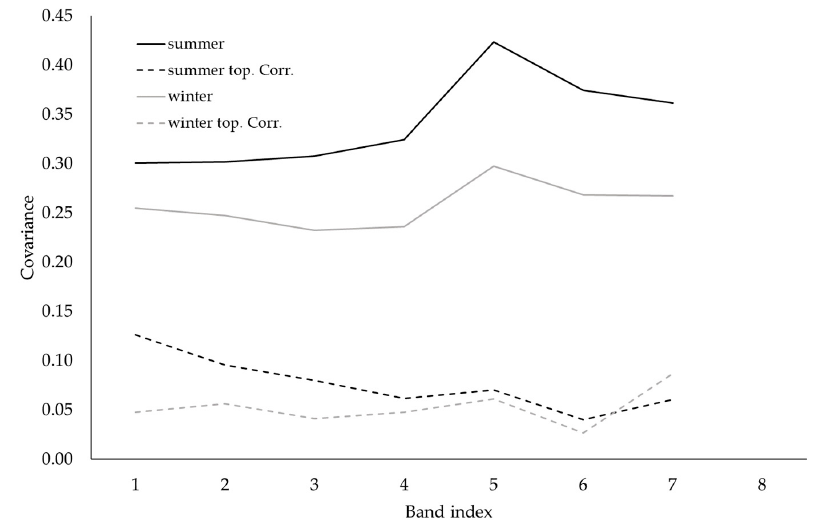
Figure 13. Correlation index between the reflectance images and the sun exposition before (solid lines) and after (dashed lines) topographic correction.